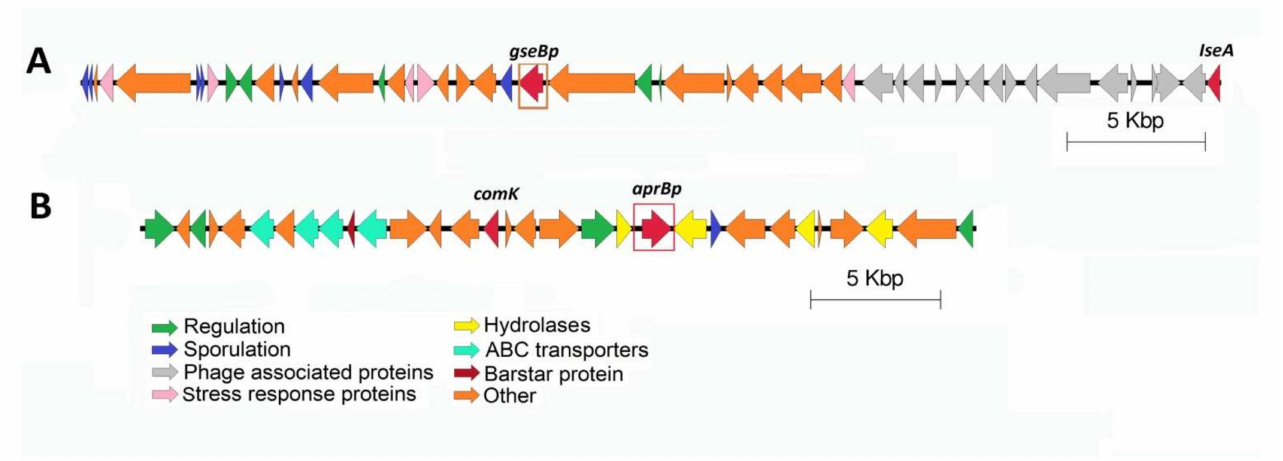
Figure 6. Alignment of genome loci containing gene of GseBp ( A ) and AprBp ( B ) proteases from B. pumilus 7P and 3-19